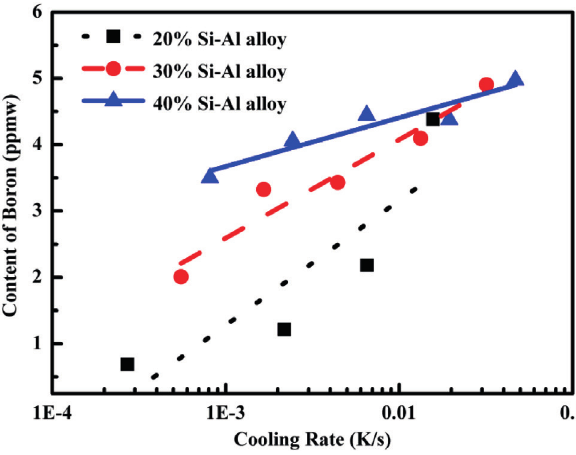
Fig. 1: Content of boron in primary silicon